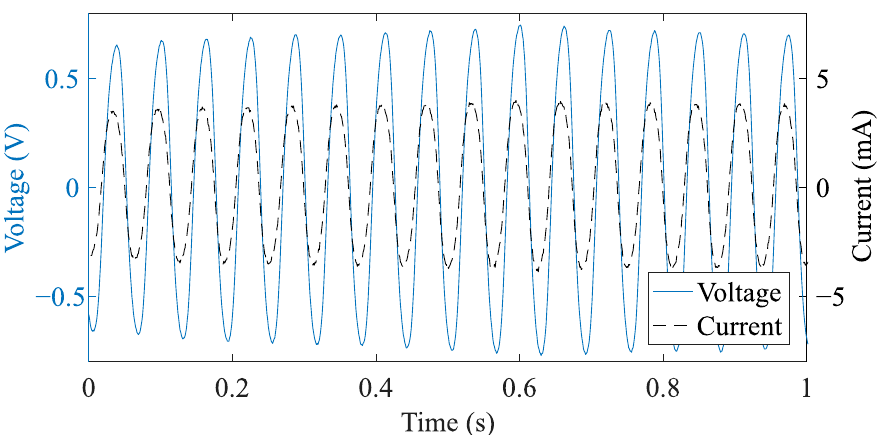
Figure 12. Measured waveforms of transient voltage and current, exemplified for a matched load condition, R Load = 180.5 Ω and C Tuning = 160µF, for the VREH operating at